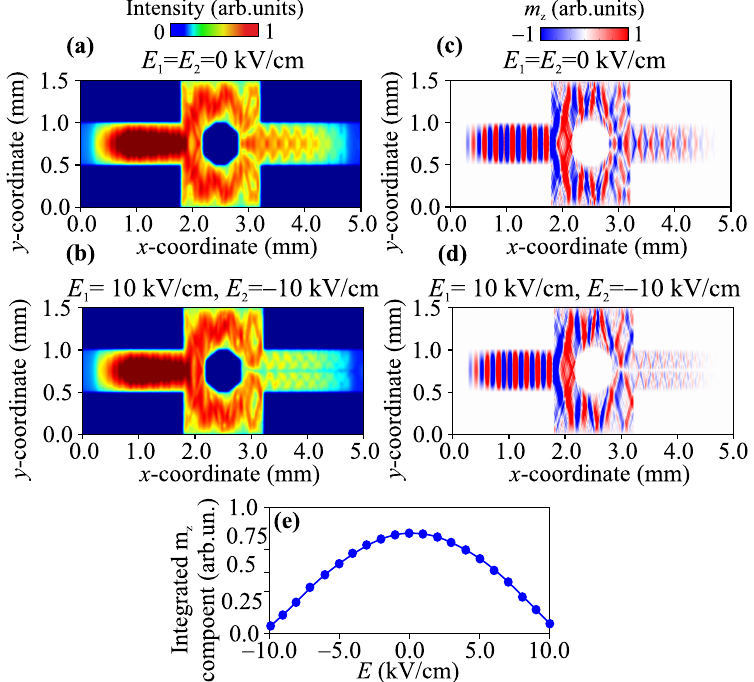
Figure 2. Spin-wave intensity maps ( a , b ) and m z -component ( c , d ) of the dynamic magnetization for E 1,2 = 0 kV/cm ( a , c ) and E 1,2 = ± 10 kV/cm ( b , d ). ( e ) Integrated value of the dynamic magnetization m z -component in the output section as a function of the external electric